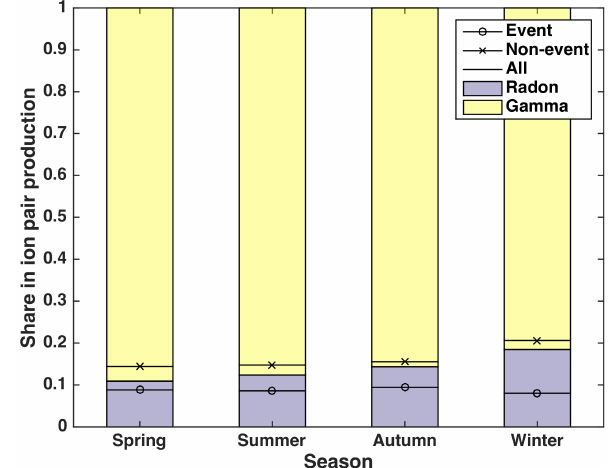
Figure 4. The relative importance of alpha and beta activities from 222 Rn and its short-lived daughter nuclides as well as total gamma radiation in air ion production. The division of the share between radon and gamma fractions on all days is indicated by a plain line, on new particle formation (NPF) event days by a line with an open circle and on non-event days by a line with a